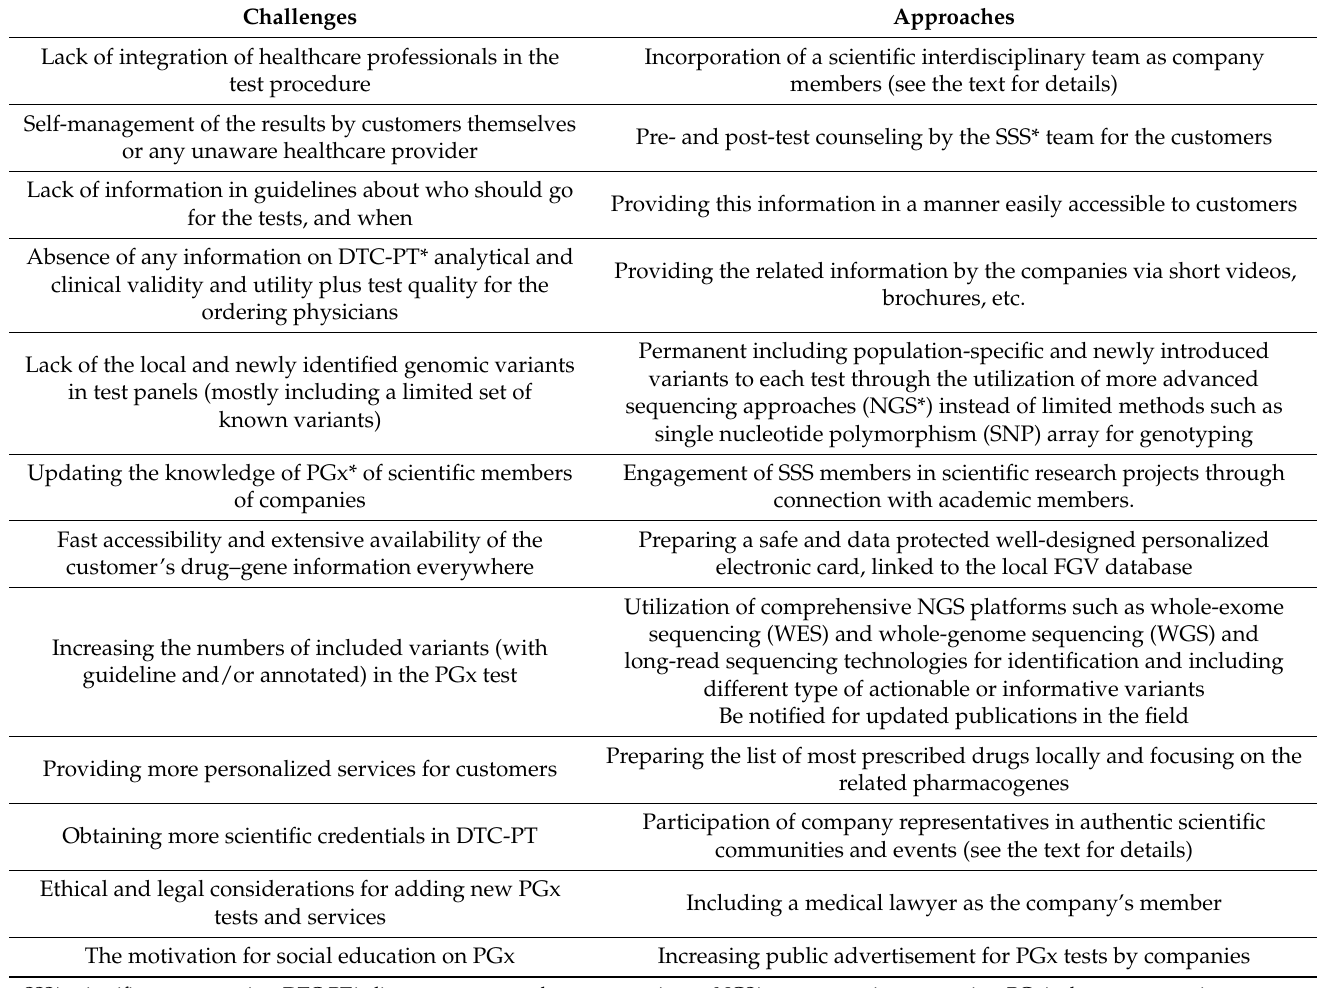
Table 2. Challenges and suggestive strategies to improve the clinical outcomes and market usability of